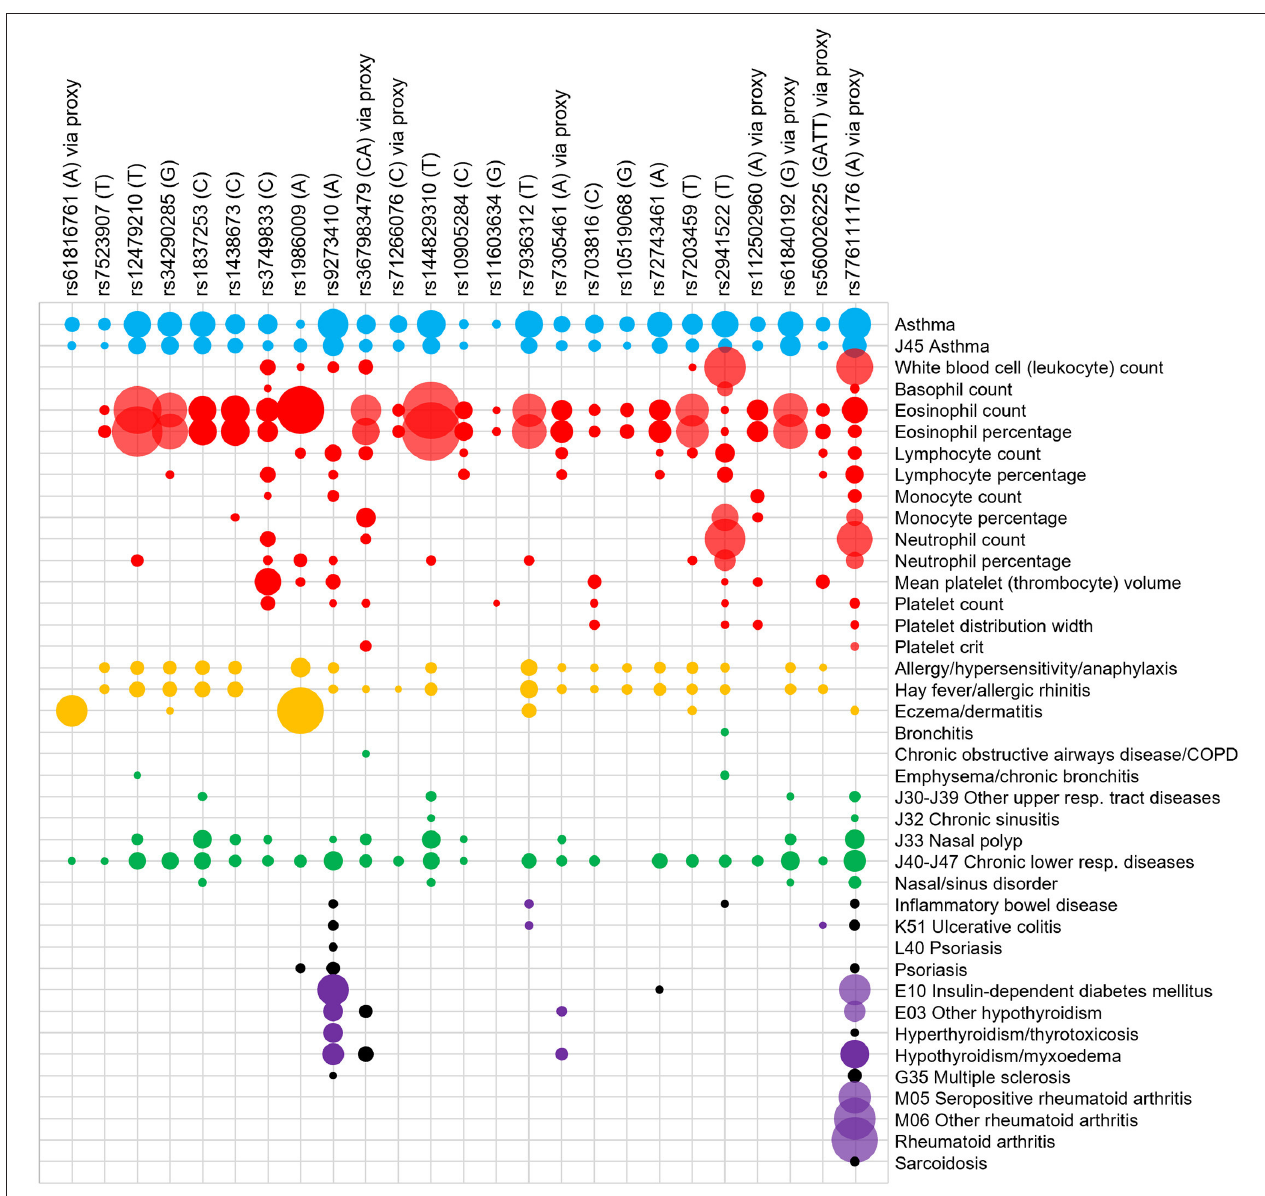
FIGURE 2 | PheWAS of signals for moderate-severe asthma. Signals (risk allele in brackets) or their proxies were searched for in the GeneATLAS PheWAS database of the UK Biobank cohort. A Bonferroni adjusted p -value of 6.42 × 10 − 5 was used. The interaction between signals (top) and PheWAS traits (right) are represented on a grid and the area of the circle represents the -log 10 ( p -value) of the association. A larger area indicates a lower p -value. Only selected PheWAS traits have been displayed and organized into asthma (blue), blood/immune cell (red), allergy (yellow), other respiratory (green), inflammatory (purple), and auto-immune (gray) groups. The trait “basophil percentage” did not meet the Bonferroni corrected P -value for any of the signals and therefore was not included in the Figure. A full list of PheWAS terms and Beta and P -values are available in Supplementary Table 1 . For disease traits (i.e., all except blood cell traits) a black dot represents an odds ratio of < 1 with respect to the moderate to severe asthma risk allele. Proxies were used for the following signals which were not present in the database: rs61816761 (rs61816766, R 2 = 0.50), rs367983479 (rs1504215, R 2 = 0.85), rs71266076 (rs7824993, R 2 = 0.81), rs7305461 (rs1131017, R 2 = 0.75), rs112502960 (rs62076439, R 2 = 1.0), rs61840192 (rs1031163, R 2 = 1.0), rs560026225 (rs72687036, R 2 = 0.66), and rs776111176 (rs3997872, R 2 =